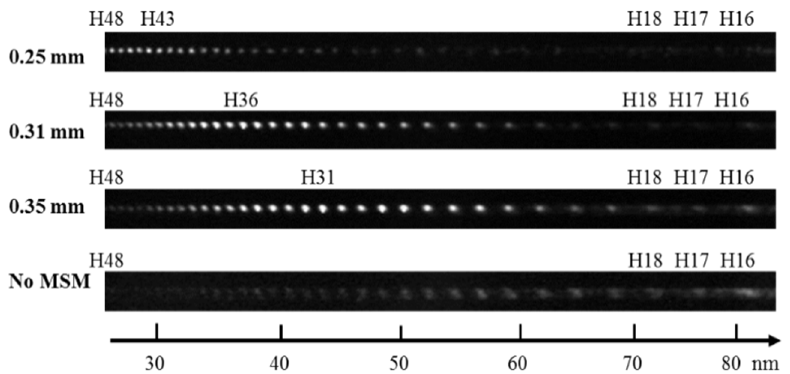
Figure 3. Raw images of harmonic spectra from the multi-jet silver LPP produced using tilted MSM with single plasma jet sizes of (top to bottom) 0.25, 0.31, and 0.35 mm pumped by two-color (1310 nm + 655 nm), 70 fs pulses. The intensities of 1310 nm and 655 nm pumps in plasma area were 1.3 × 10 14 and 1 × 10 13 W cm − 2 , respectively. Maximally enhanced harmonics (H43, H36, and H31) are determined for each of these plasma configurations. Bottom spectrum corresponds to homogeneous extended silver plasma. Similar conditions of plasma ablation using the same energy fluence of heating pulses and data collection times are applied for these four